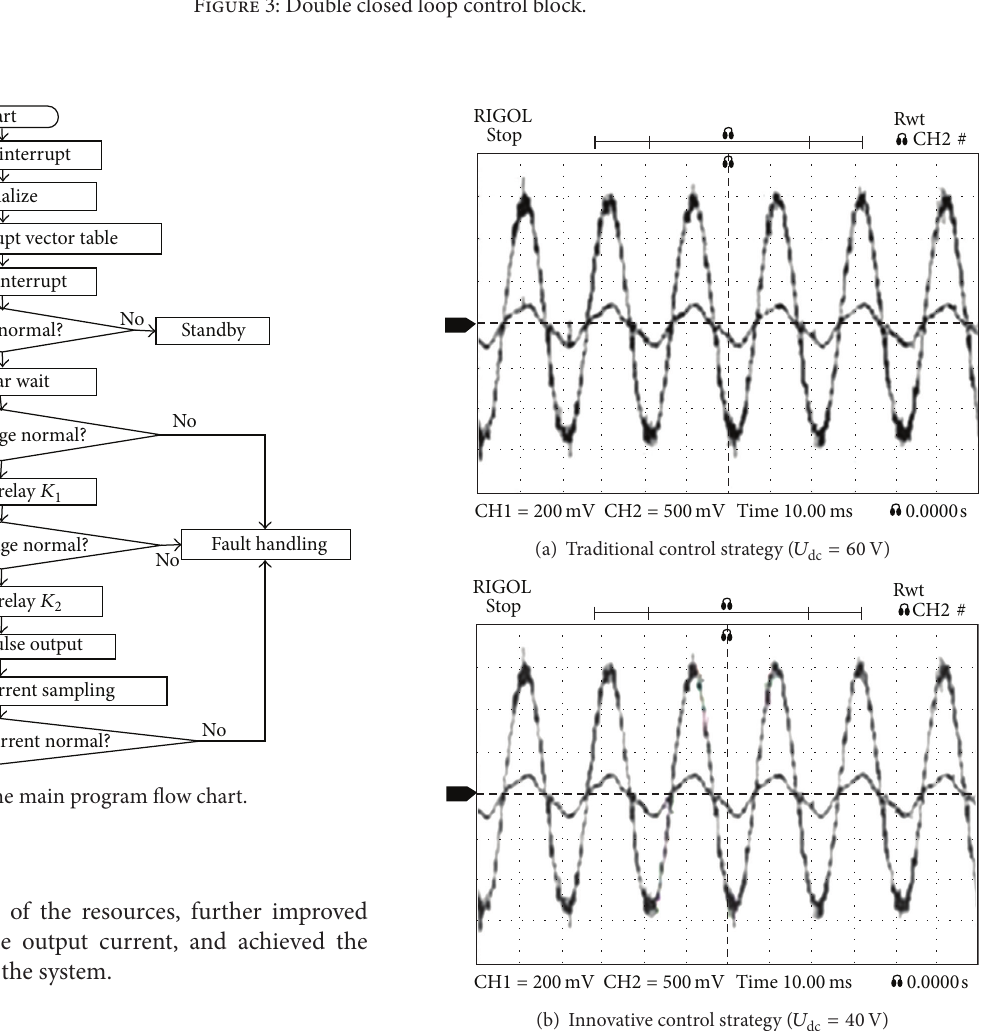
Figure 3: Double closed loop control block.